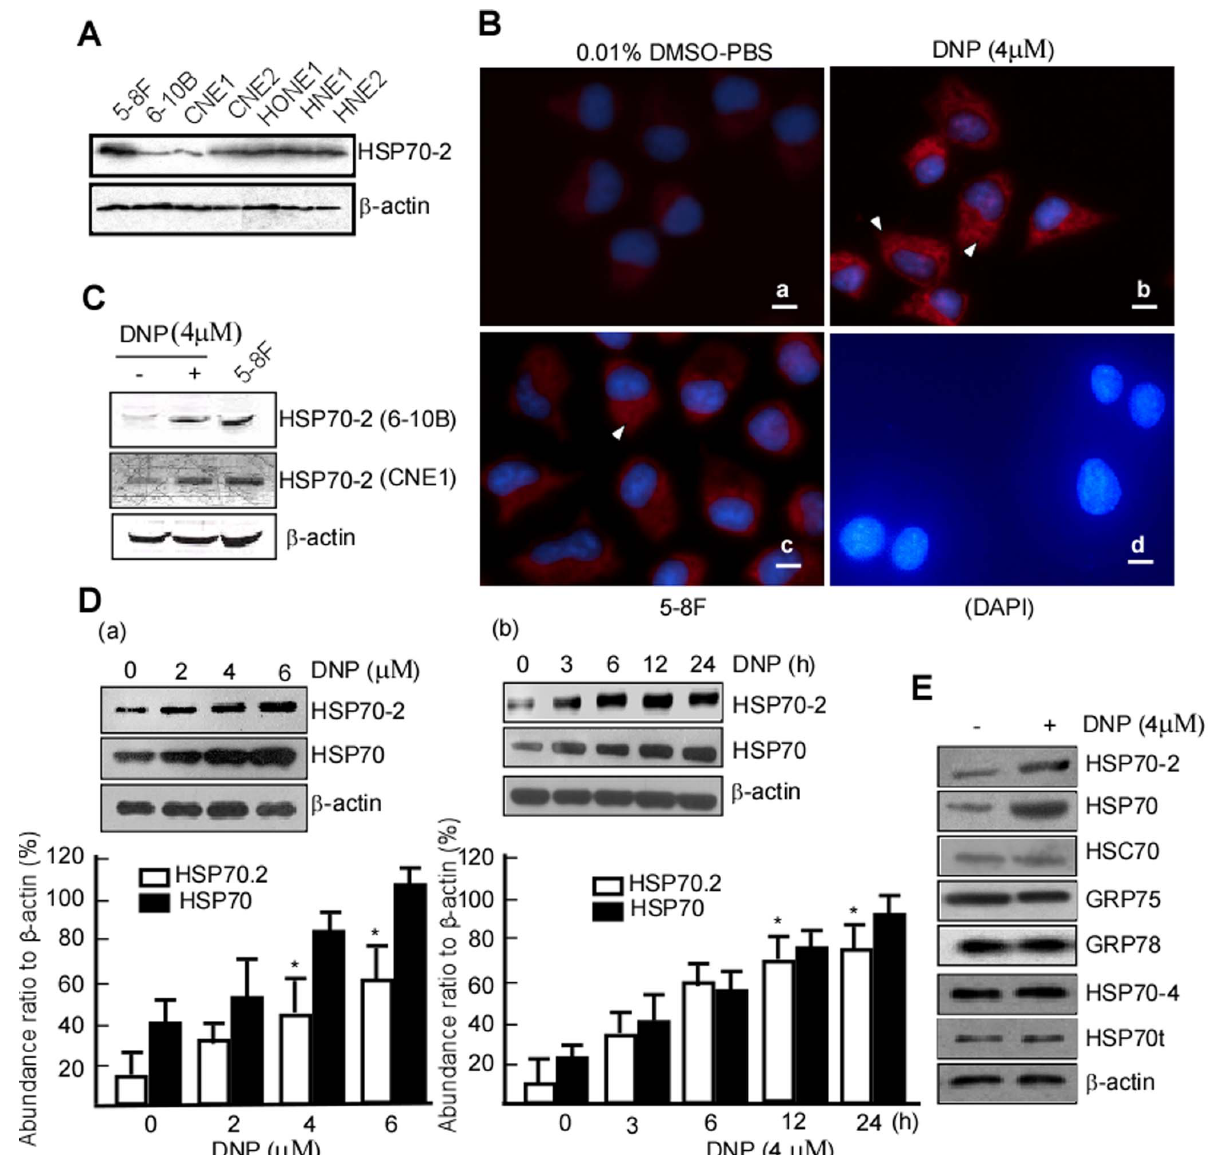
Figure 2. Dose- and time- dependent DNP-mediated HSP70 expression. A, HSP70-2 expression was detected in NPC cell lines 5-8F, 6-10B, CNE1, CNE2, HONE1, HNE1, and HNE2 by Western blotting. B, DNP-mediated HSP70-2 expression was detected using immunofluorescence. a, 6-10B cells treated with 0.1% DMSO-PBS served as a negative control; b, 6-10B cells treated with DNP; c, 5-8F served as a positive control; d, 6-10B cells stained with DAPI. Scale bar=50 m m. C, DNP-mediated HSP70-2 expression was detected in 6-10B and CNE2 cells. D, Time- and dose-dependency of DNP-induced HSP70-2 expression. a, HSP70-2 expression in 6-10B cells treated with the indicated concentration; b, HSP70-2 expression in 6-10B cells with 4 m M DNP for the indicated time. Three independent experiments were performed, the abundance ratio to b -actin was counted, and data are represented as means 6 SD from three experiments. *, p , 0.05. E, Expression of HSP70-2, HSP70t, HSC70, GRP75, GRP78, and HSP70-4 was detected in 6-10B cells after DNP